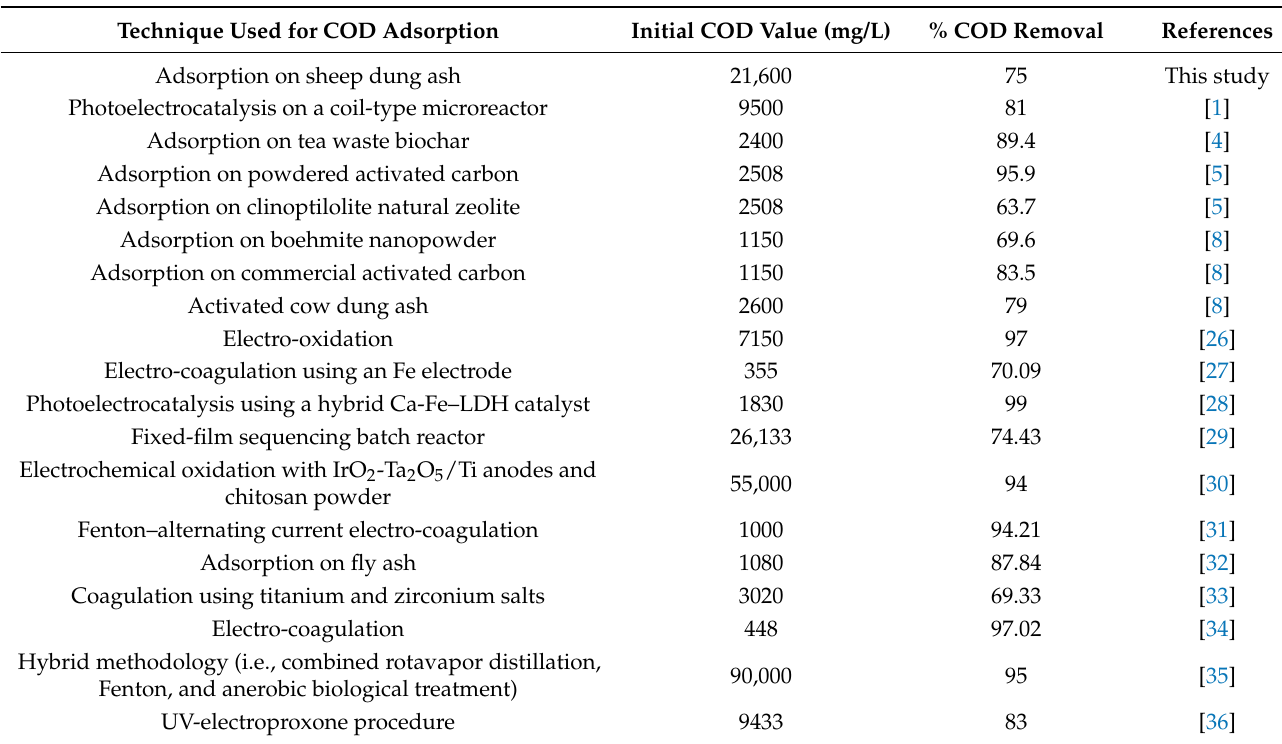
Table 3. Comparison of COD removal efficiency of sheep dung ash with that of some other adsorbents and techniques in the